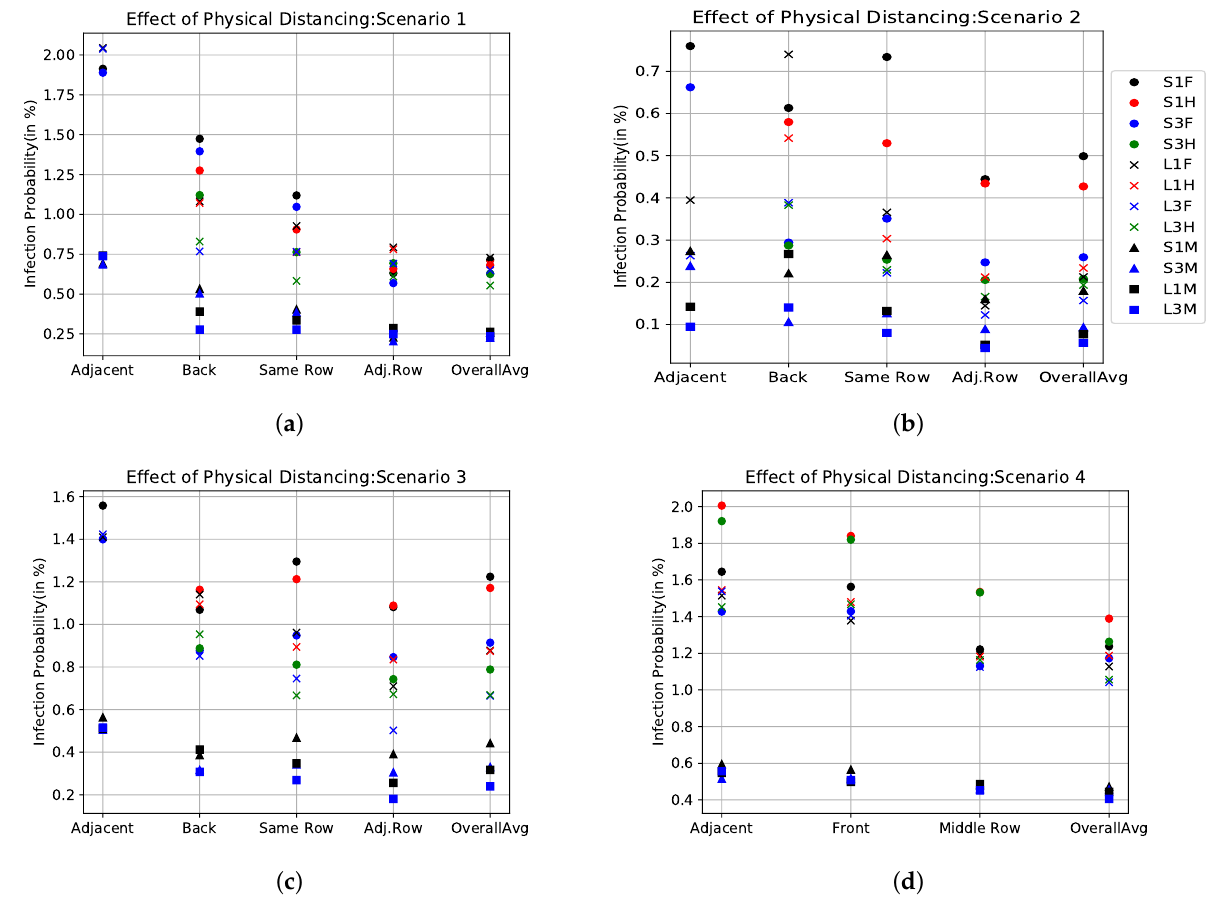
Figure 10. Effect of physical distancing for ( a ) Scenario 1, ( b ) Scenario 2, ( c ) Scenario 3, ( d ) Scenario 4. The keys in the legend with prefix ‘S’ and ‘L’ refer to AP placed on the short side and long side of the room, respectively. The numerical suffix refers to the volumetric flow rate level of the AP. The suffixes ‘F’, ‘H’, and ‘M’ refer to cases with the classroom operating at full capacity, half capacity, and full capacity with surgical masks,